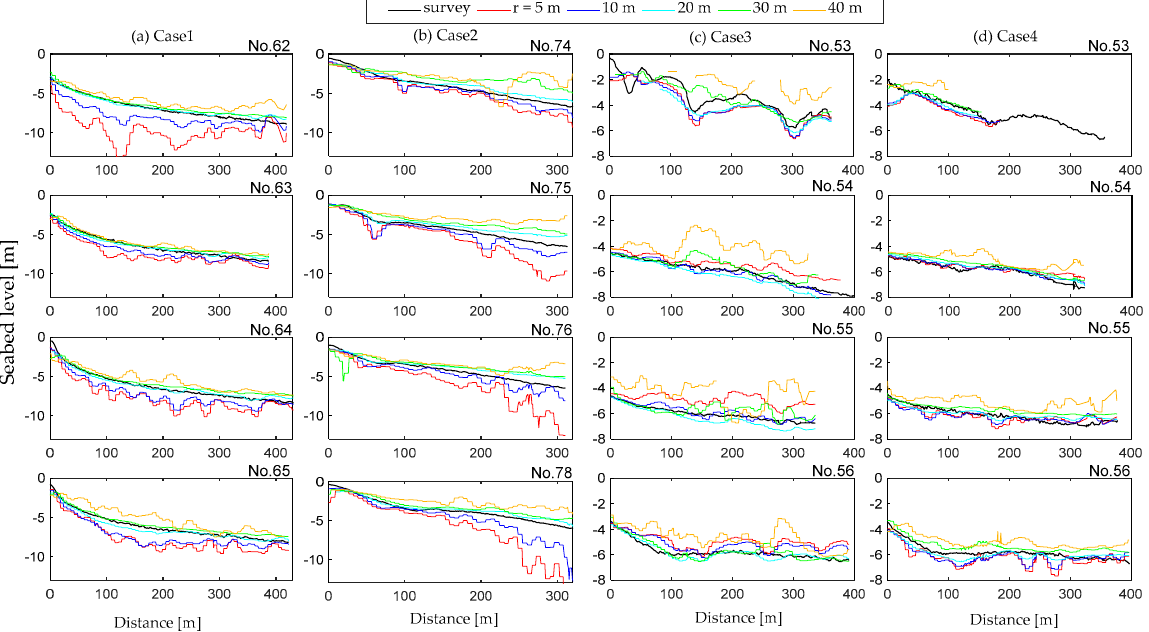
Figure 12. Estimated seabed level along the survey transects computed with r = 5, 10, 20, 30 and 40 m: ( a ) Case 1, ( b ) Case 2, ( c ) Case 3 and ( d ) Case 4.